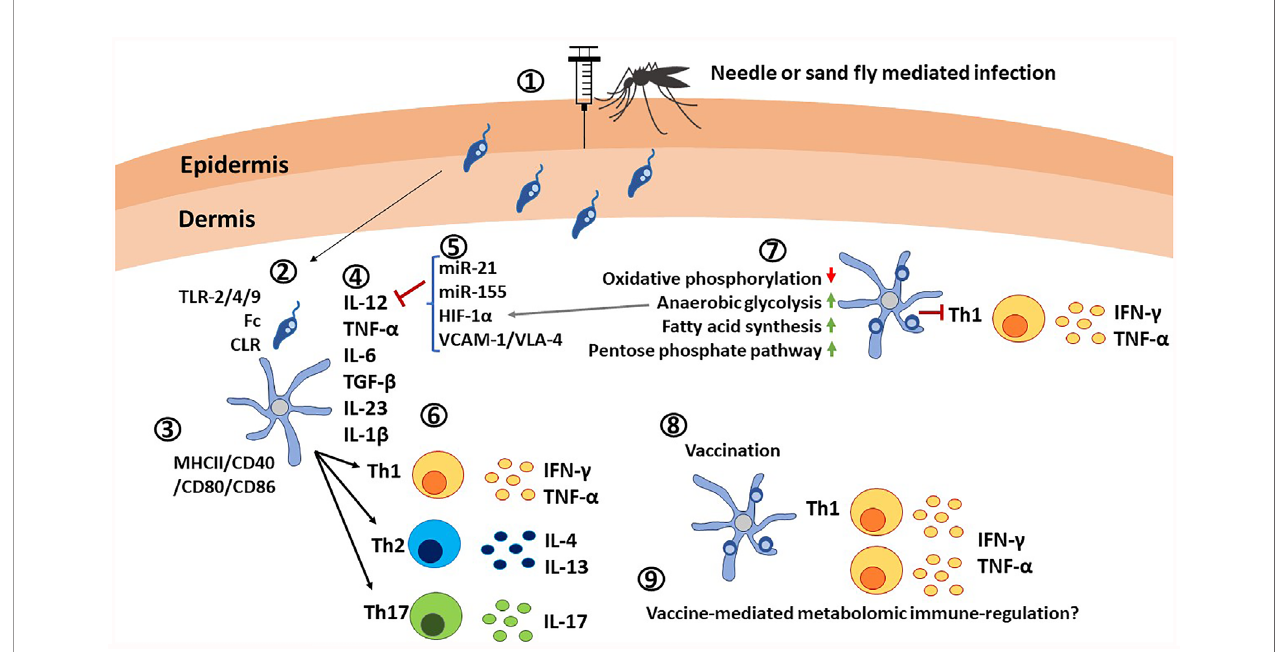
FIGURE 4 | Critical roles of dendritic cells in immunity against Leishmania parasites. 1) Leishmania promastigotes are injected into the host via needle injection or sand fl y injection. 2) DCs interact with Leishmania parasites through TLR-2/4/9, Fc receptors and C-type lectin receptors. 3) Activation of DCs is indicated by the elevated expression of MHC-II/CD40/CD80/CD86. Leishmania infections also causes expression of co-inhibitory molecules. 4) DCs are the main producers of IL-12 in addition to TNF- a , IL-6, TGF- b , IL-23, and IL-1 b , which determine the differentiation of naïve T cells. 5) Expression of IL-12 is affected by microRNAs, transcription factors such as HIF-1 a and ligands such as VCAM-1/VLA-4. 6) Upon interaction with DCs in lymphoid tissues in presence of cytokine signals, naive T cells differentiate into Th1, Th2 or Th17 cells and produce pro-in fl ammatory cytokines IFN- g , TNF- a , or anti- in fl ammatory cytokines IL-4, IL-13 or IL-17. 7) Infected DCs are characterized by upregulation of anerobic glycolysis, fatty acid synthesis, pentose phosphate pathway, and by down regulation of oxidative phosphorylation, which results in poor expansion of Th1 cells. 8) Vaccination with live attenuated Leishmania parasites has shown elevated IL-12 production and expansion of Th1 cells. 9) Similar to other innate immune cells, metabolomic immune regulation in DCs upon vaccination remains an unexplored